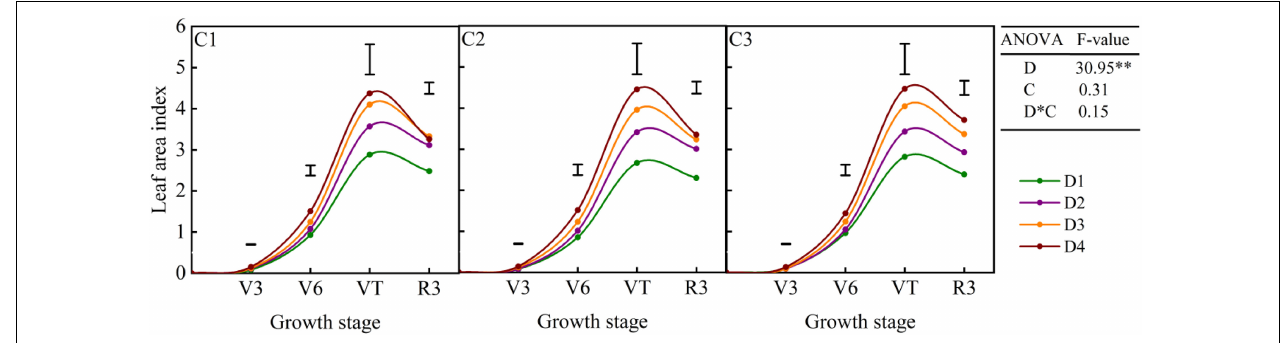
FIGURE 3 | Dynamics of the leaf area index (LAI) of dryland maize under different planting densities and cultivar treatments. D1: 52,500 plants ha − 1 ; D2: 67,500 plants ha − 1 ; D3: 82,500 plants ha − 1 ; D4: 97,500 plants ha − 1 ; C1: Yuyu22; C2: Zhengdan958; C3: Xianyu335; D, planting density; C, cultivar. Data represent the average values over the experimental period (2013–2018). Vertical bars represent the LSD value at p <